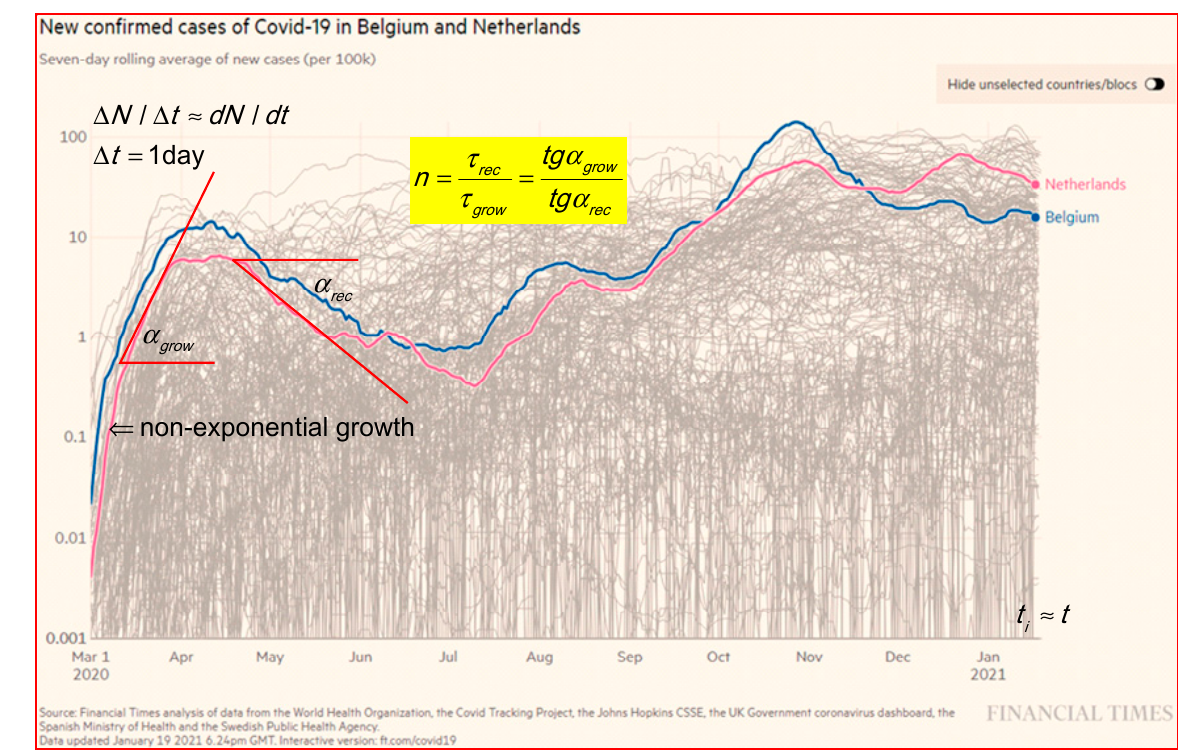
Figure 2. The epidemic curve in log–lin for new confirmed cases in Belgium and the Netherlands [1]. Results are taken over 7 days, d to smooth out the fluctuations and normalized on 10 5 to better compare countries with different populations. The two tangent lines and slope angles are an indication for the analysis in a ratio of τ -values. Some peaks in the log–lin presentation at a level on a factor of 30 below the main peaks are hardly visible in a linear presentation.